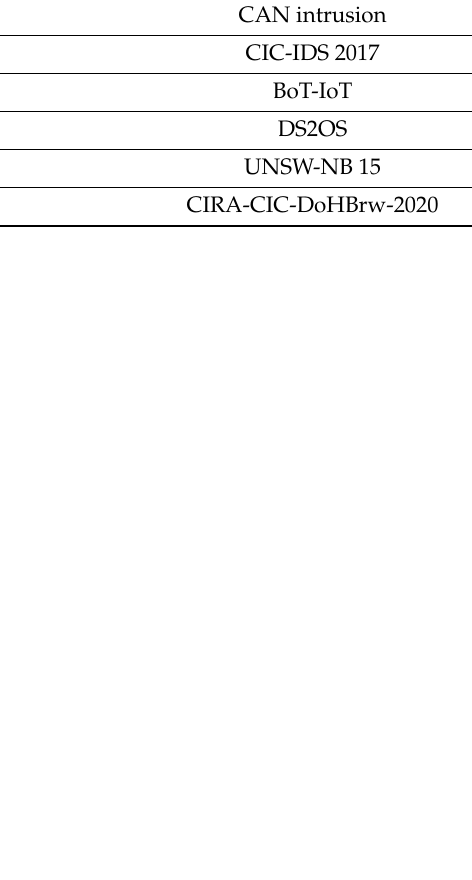
Figure 8. CAN-intrusion dataset description.